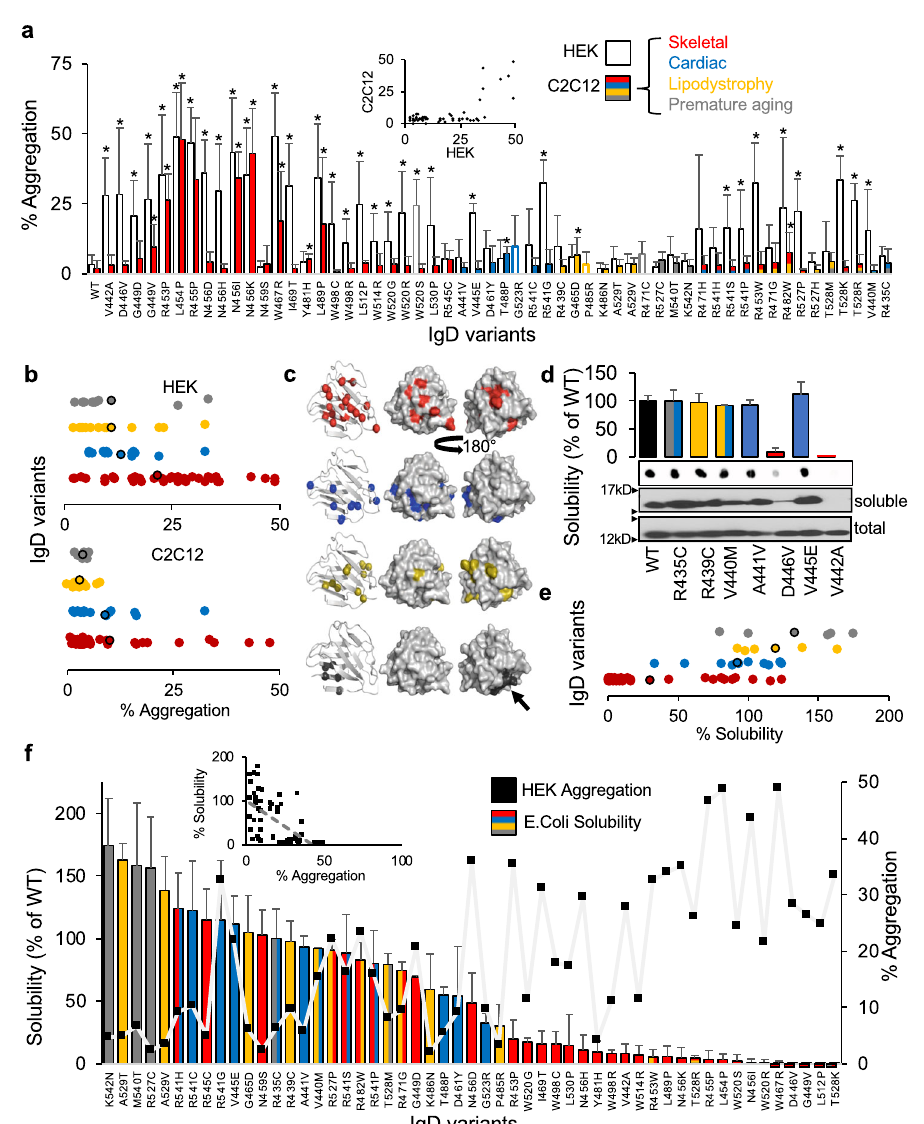
Fig. 3 Lamin A aggregation for IgD variants. a Percentage (%) of cells showing lamin A aggregation are plotted for each variant (mean ± SD, n ≥ 3). C2C12 myoblast variants are color-coded as follows: skeletal disease-associated variants in red, cardiac in blue, lipodystrophy in yellow, progeria in gray. HEK 293 results are plotted in white. Inset shows the correlation between HEK 293 cells and C2C12 myoblasts. b % aggregation distribution for all IgD variants grouped by phenotype for HEK 293 cells and C2C12 myoblasts with average values outlined in black. c Variants, color-coded as above, are mapped to regions of the IgD structure by disease (red, blue, yellow, and gray balls). The fi rst structure shows the location of each variant followed by surface representations with the last one rotated 180°. Arrow indicates surface patch where progeria-linked variants are located. d Representative immunoblots for recombinant IgD variants expressed in E. coli . Bars represent relative solubility (% of WT) determined by dot blot for each variant (mean ± SD, n ≥ 3). e Relative solubility distribution (% of WT determined by dot blot) for all IgD variants grouped by phenotype ( n ≥ 3) with average values outlined in black. Variants with crossover disease are plotted more than once for each phenotype. f Solubility results plotted along with the HEK 293 aggregation results for comparison with inset showing an inverse relationship between aggregation and solubility. Asterisks indicate statistically signi fi cant increases in aggregation over WT ( p < 0.05). IgD immunoglobulin-like